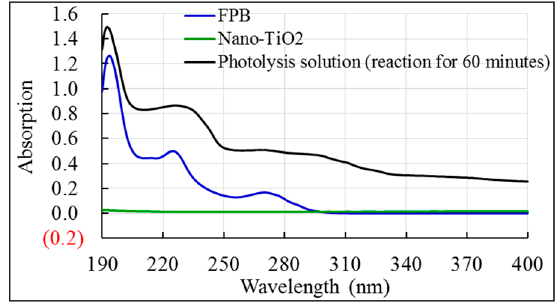
Figure 1. The ultraviolet absorption spectra of FPB (Fluazifop-p-butyl), nano-TiO 2 and FPB photodegradation in the presence of nano-TiO 2 .